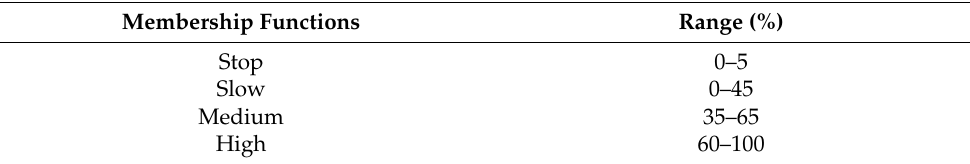
Table 5. Membership Functions for the Heater.